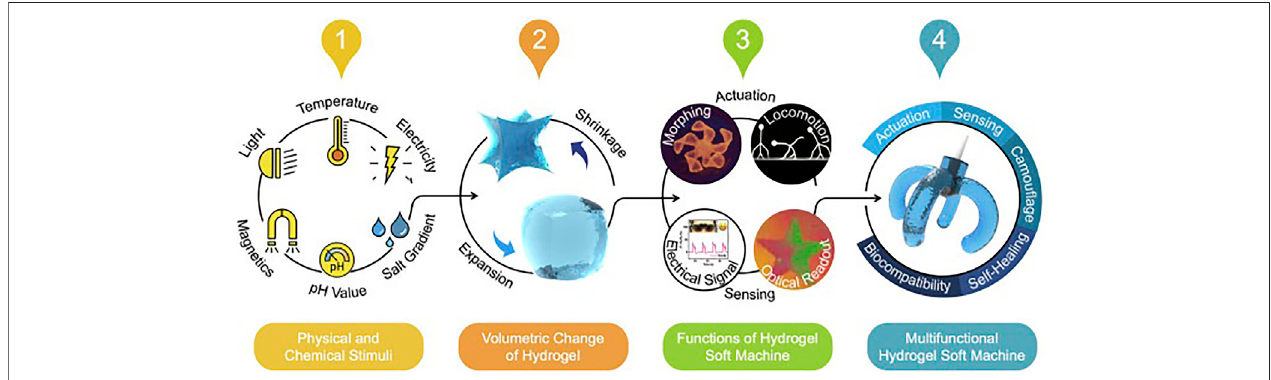
FIGURE4| Schematicillustrationofthehydrogel-basedstimulus-responsivesoftsessionandactuationfeaturessuchasshapemorphing(Fuetal.,2018),locomotion (DeForest and Anseth, 2012), sensing with electrical signal output (Morales et al., 2014), and sensing with optical readout (Ashley, 2003). Copyright 2020, Elsevier.